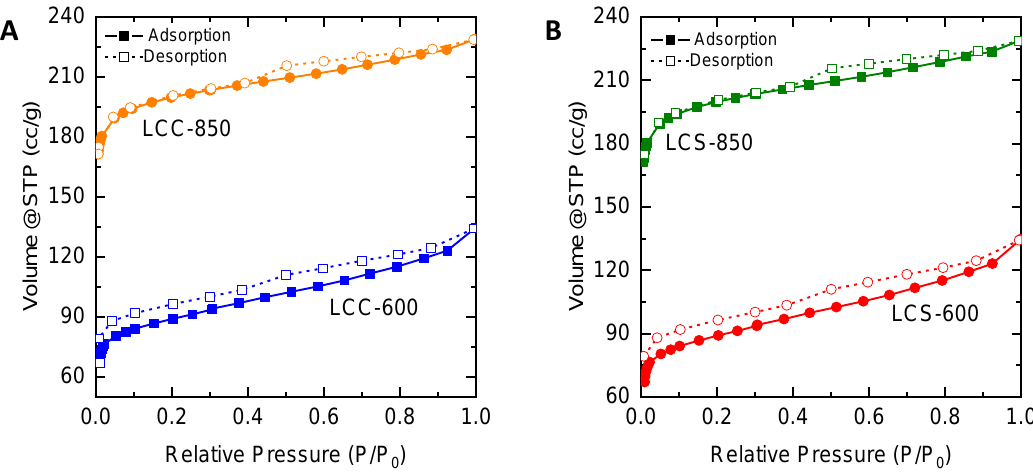
Figure 6. Adsorption and desorption of nitrogen in carbon ( A ) corncob lignin; ( B ) coconut shell lignin.